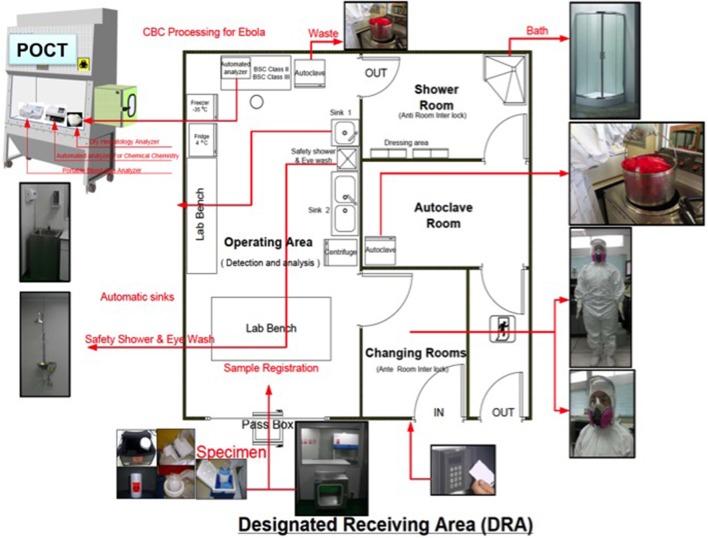
Design of an isolation laboratory with POCT inside a Biosafety Cabinet. This discrete spatial solution, an isolation laboratory design built in several Bangkok locations, offers vital engineering controls that reduce the risk of biohazards while also providing environmental temperature and humidity conditions for the proper operation of POC instruments. Personnel must practice donning personal protective equipment (PPE), then performing testing, followed by careful doffing, training that now is being implemented in US sites, such as the Center for Disaster Medicine at Massachusetts General Hospital (see https://www.massgeneral.org/News/newsarticle.aspx?id=7175). Image reproduced with permission of Knowledge Optimization.